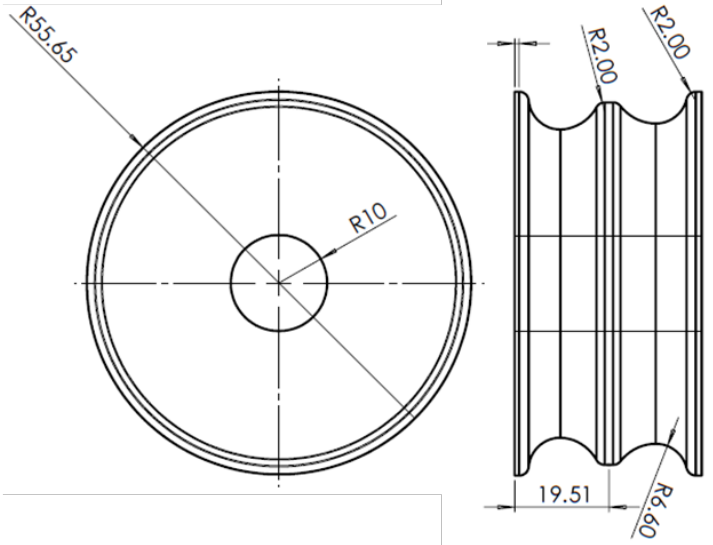
Figure 7. Roller front and side views with geometric dimensions. All dimensions are in mm.